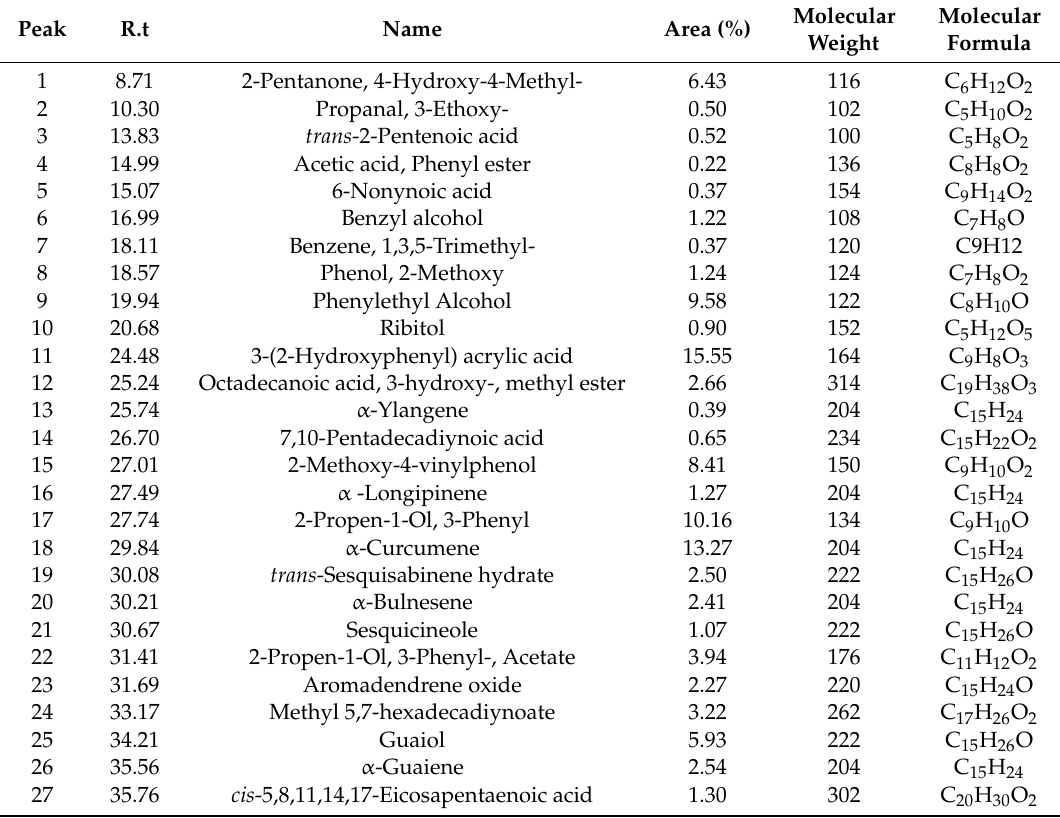
Table 1. The chemical composition of MEBV by GC-MS.